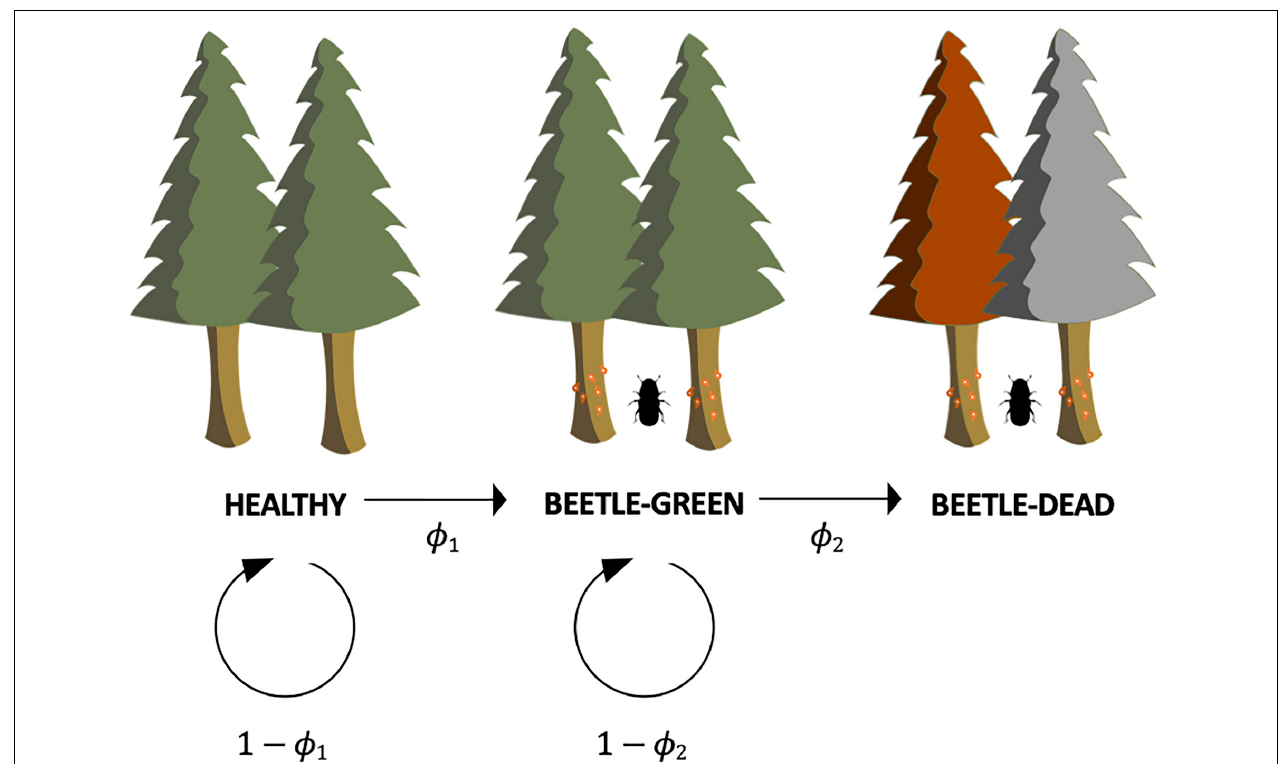
FIGURE 1 | Conceptual framework of the MCMC model used to estimate probabilities of any given tree being healthy (1 − φ 1 ), beetle-green [ φ 1 × ( 1 − φ 2 ) ], and beetle-dead ( φ 1 × φ 2 ). Beetle-dead trees included trees in both beetle-red and beetle-gray phases. Due to the predictable beetle-red phase in lodgepole pines 1 year after succumbing to beetles, we used a separate model approach that only included beetle-red trees to assess year-to-year probabilities of mortality for that